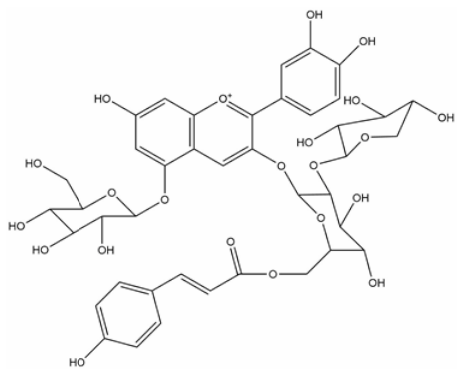
Figure 1. The chemical structure of anthocyanin.